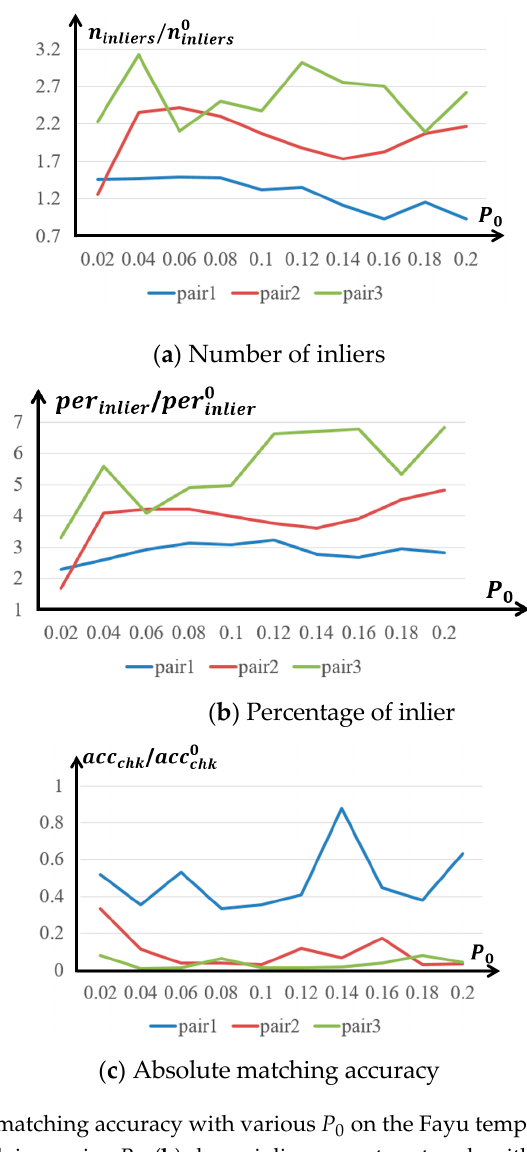
Figure 6. The trend of matching accuracy with various P 0 on the Fayu temple dataset. ( a ) shows the inlier number trend with increasing P 0 ; ( b ) shows inlier percentage trends with increasing P 0 ; ( c ) shows the absolute matching accuracy trends with increasing P 0 .